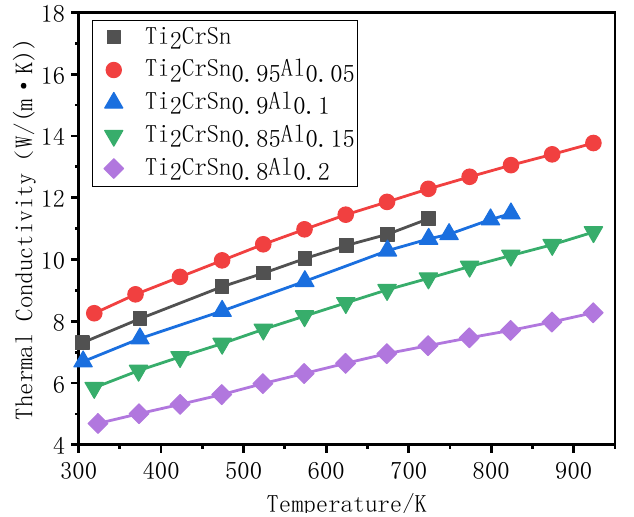
Figure 6. Variation of thermal conductivity with respect to temperature for Ti 2 CrSn 1-x Al x (x = 0, 0.05, 0.1, 0.15, 0.2).